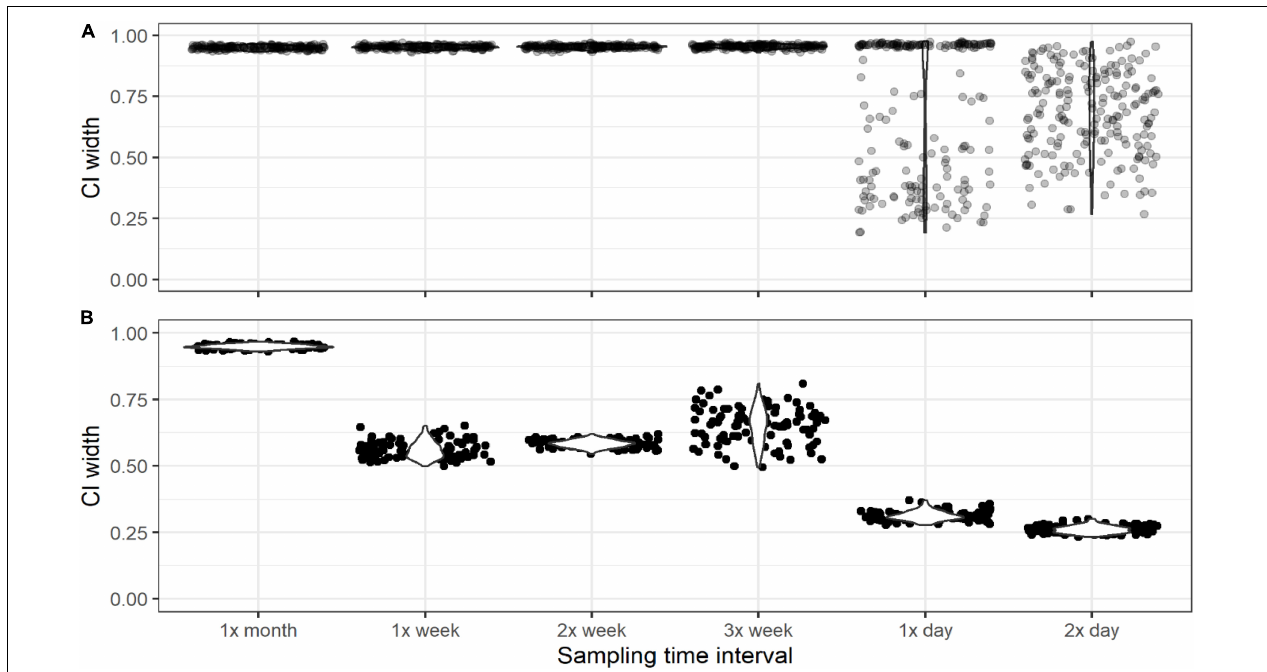
FIGURE 8 | The difference between the 95% and 5% confidence intervals (CI width) of the posterior mean of θ for simulations of Yellowstone River (A) and Snake River (B) targets when eDNA samples were collected at different daily and weekly